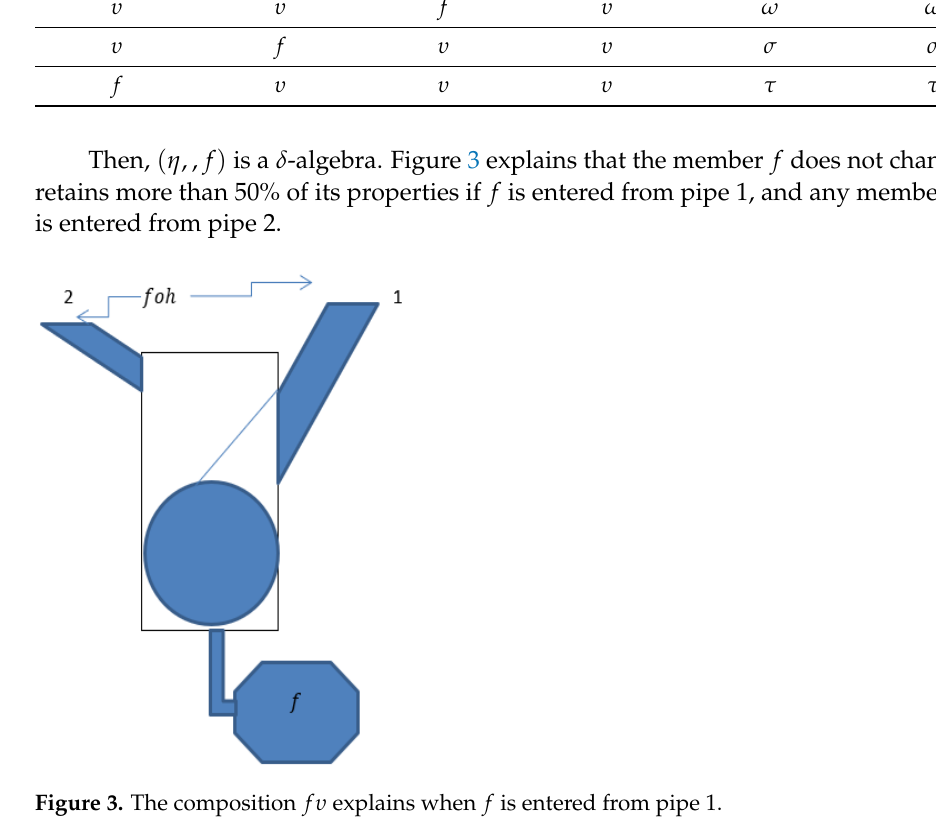
Figure 3. The composition 𝑓𝜊𝜐 explains when 𝑓 is entered from pipe 1.